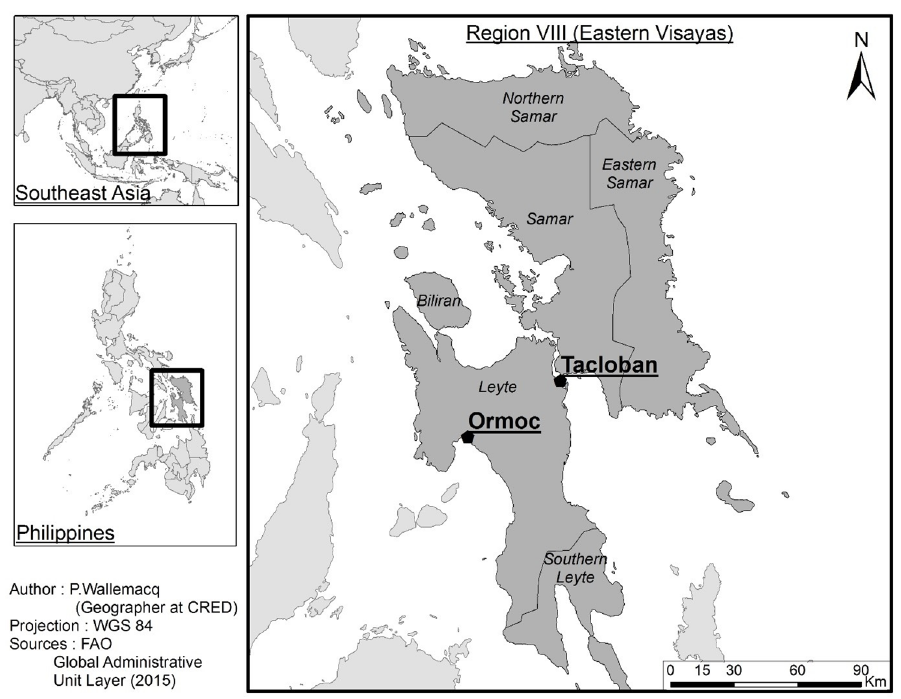
Fig 1. Representation of Eastern Visayas, the area affected by Typhoon Haiyan. The study locations are indicated on the map (Ormoc District Hospital in Ormoc, and Eastern Visayas Regional Medical Center in Tacloban).